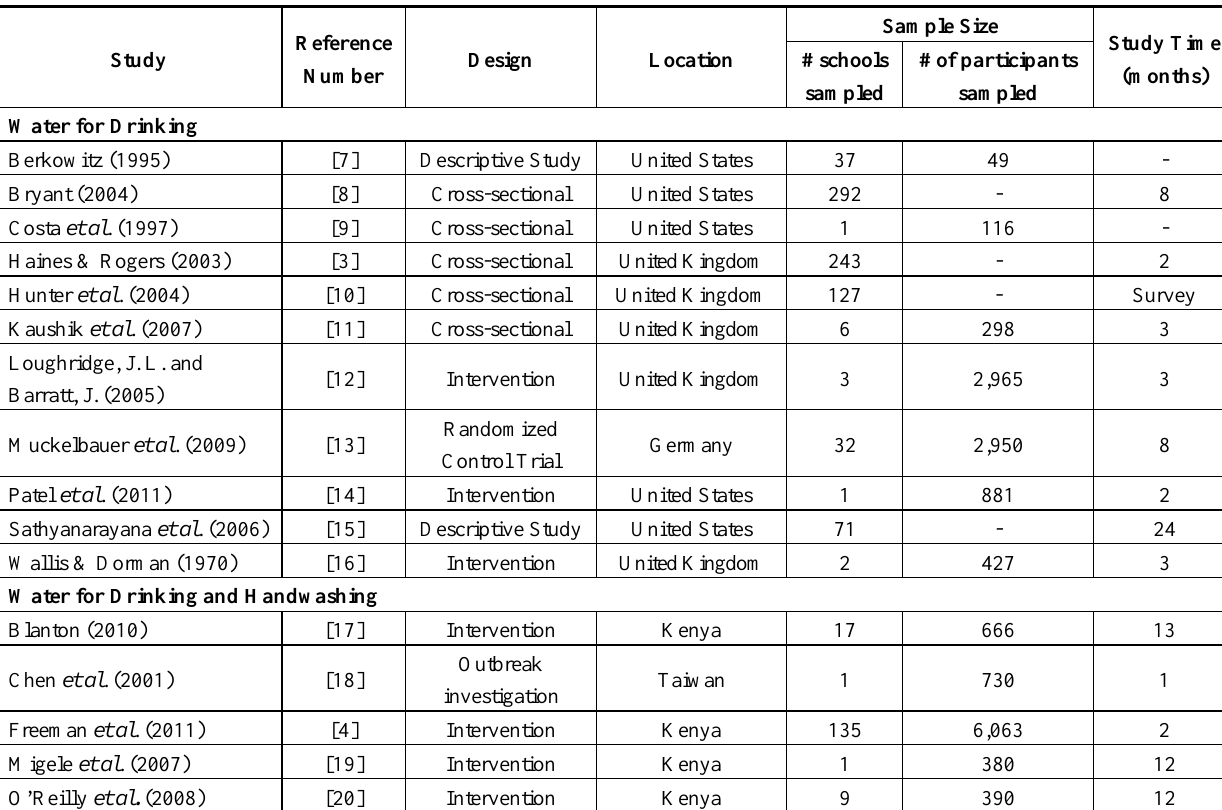
Table 3. Characteristics of studies included in the review, grouped by field examined. Dash marks indicate items not reported in the